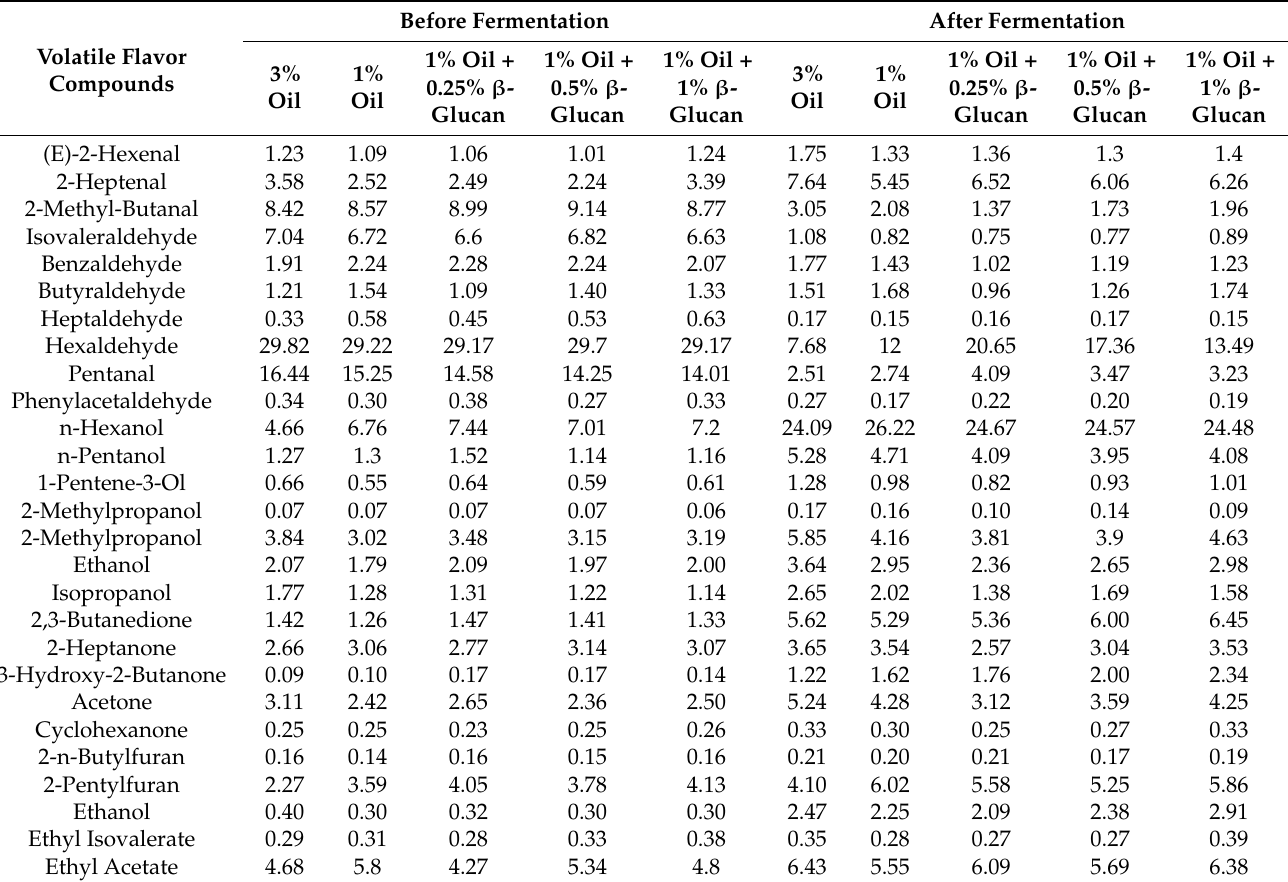
Table 3. The relative content of volatile flavor compounds before and after